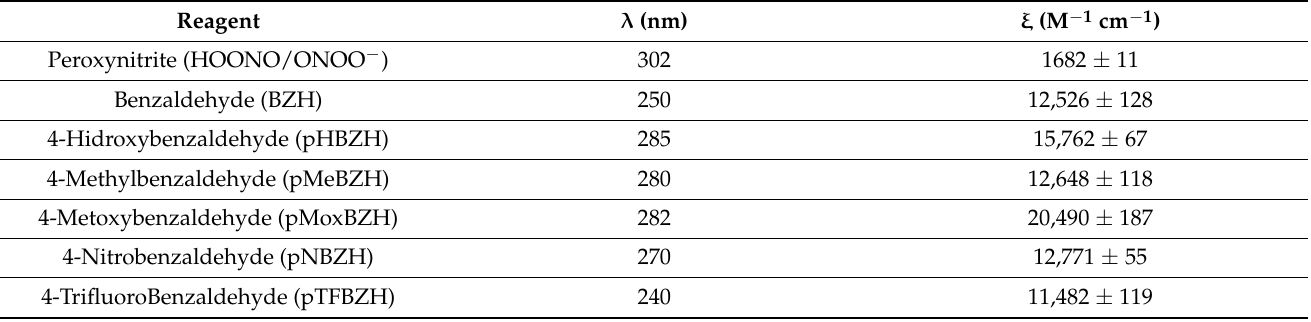
Table 2. Absorption maxima and molar absorptivity coefficients of the studied species. T = 25 ◦